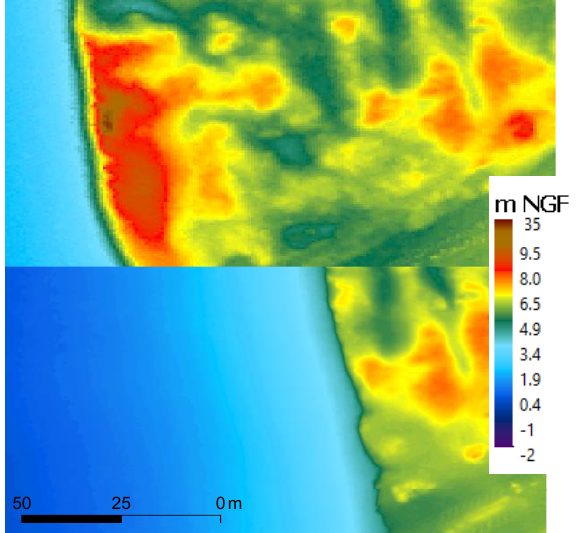
Figure 7: Comparison of the same area between Lidar 2010 (top picture) and UAV imagery 2015 (bottom picture).